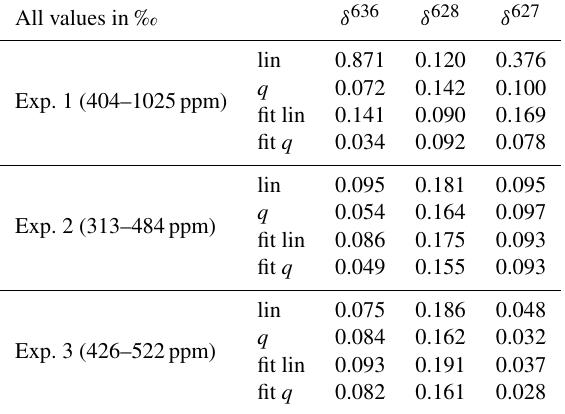
Table 3. Mean residuals for correction of the CMFD of the three measured deltas using three different scenarios; lin and q are cal- culated relations, using the linear and quadratic fit, respectively, of the rare isotopologue as a function of the abundant isotopologue. Fit and fit q are the linear and quadratic fit, respectively, of the mea- sured delta values as a function of the CO 2 mole fraction. The min- imum and maximum CO 2 mole fractions that were used per exper- iment are shown in the first